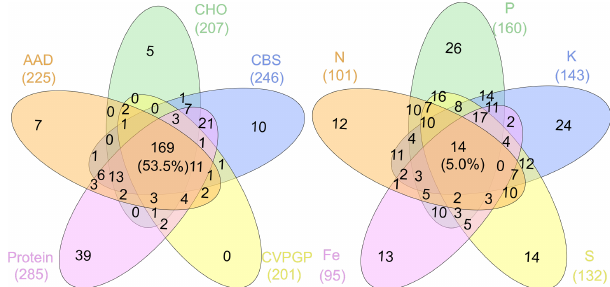
Figure 6. Venn diagrams showing the microbial taxonomic network nodes shared among broad and narrow